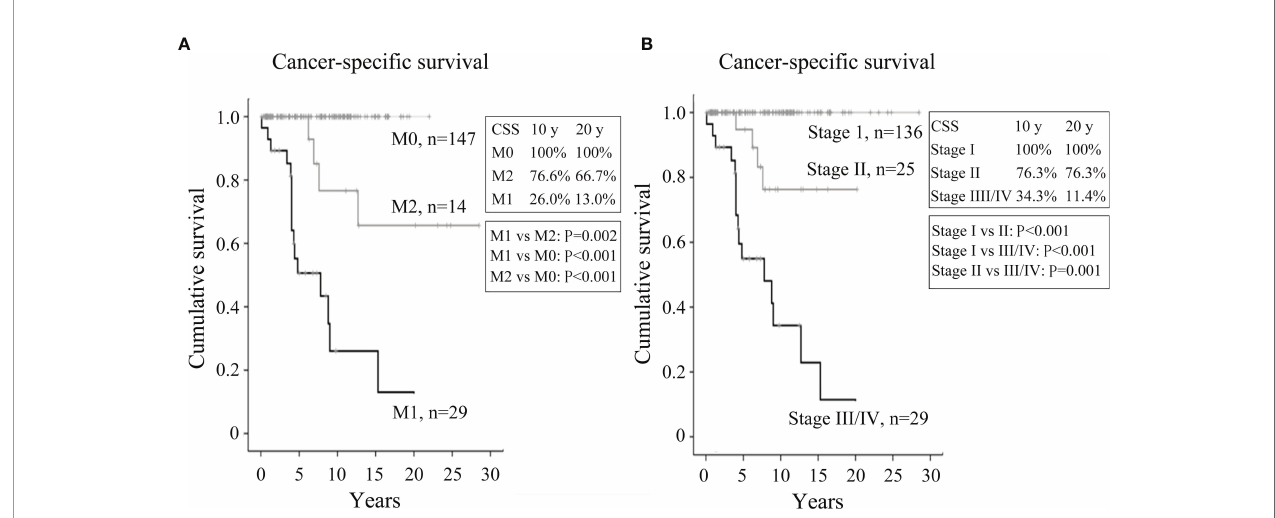
FIGURE 2 | Kaplan – Meier plots illustrating cancer-speci fi c survival of FTC patients. (A) Kaplan – Meier survival plots for patients with metastatic FTC at presentation (M1), developing metastasis during follow-up (M2), and with no evidence of metastasis (M0). (B) Kaplan – Meier survival plots for FTC patients with stage I, II, and III/IV disease at